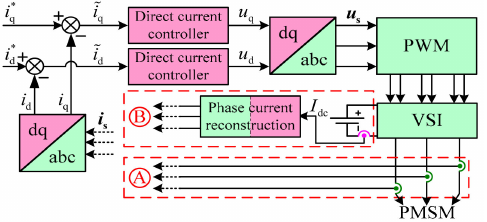
Figure 2. Diagram of conventional current control system of PMSM.